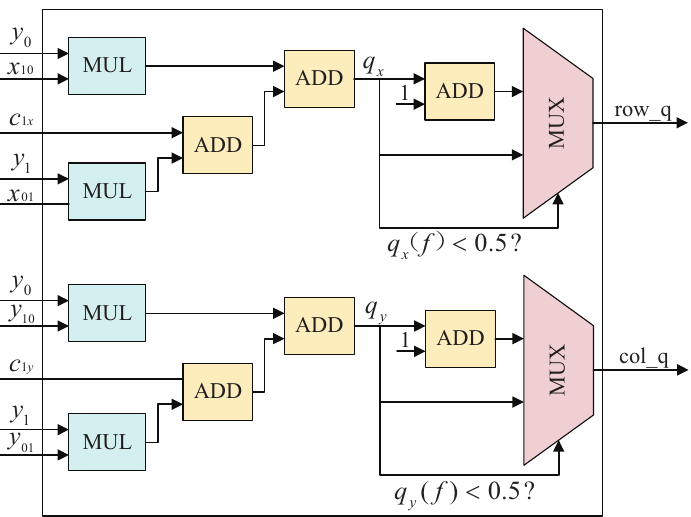
Figure 7. Calculate the coordinates of the nearest pixel using an interpolation algorithm. q x ( f ) represents the fractional part of q x , q y ( f ) represents the fractional part of q y , row _ q and col _ q represent the x -axis and y -axis coordinates of the closest pixel, respectively.